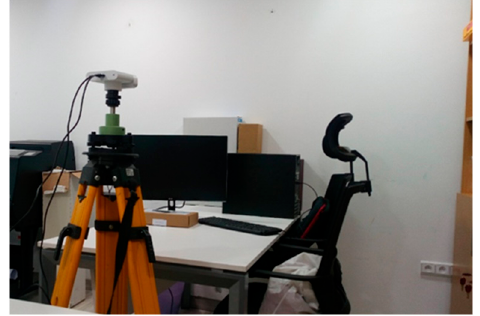
Figure 2. Indoor office scene used for testing image averaging.